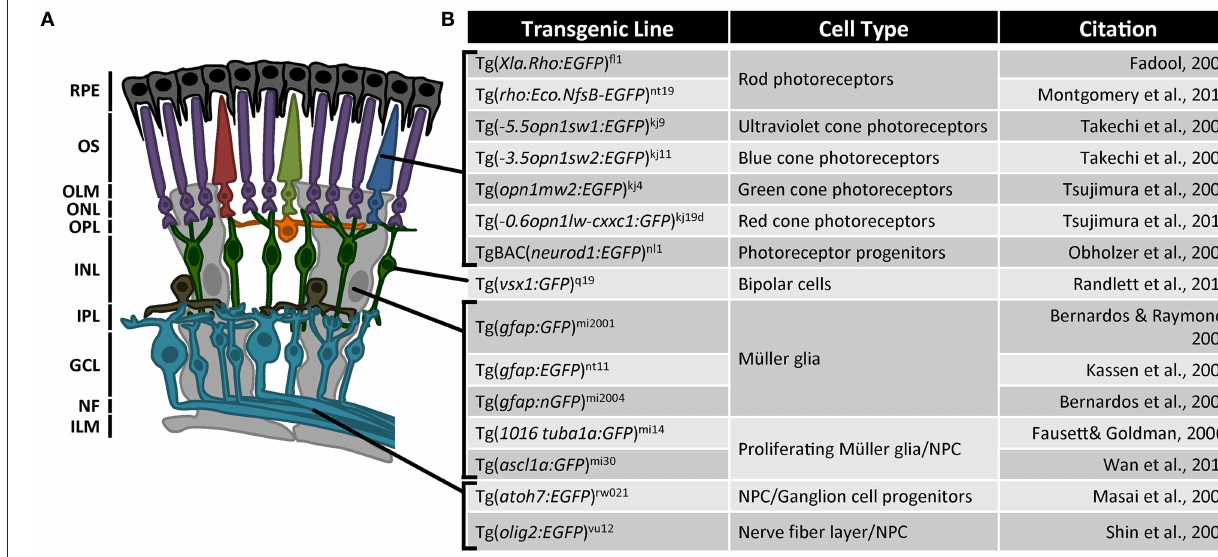
FIGURE 1 | Transgenic reporter lines used in zebrafish retinal regeneration research. (A) The vertebrate retina is a laminated structure with different neurons located in the distinct layers. RPE, retinal pigmented epithelium; OS, outer segments; OLM, outer limiting membrane; ONL, outer nuclear layer; OPL, outer plexiform layer; INL, inner nuclear layer; IPL, inner plexiform layer; GCL, ganglion cell layer; NF, nerve fibers; ILM, inner limiting membrane. (B) List of transgenic reporter zebrafish lines for retinal regeneration research. Fadool (2003), Masai et al. (2003), Shin et al. (2003), Takechi et al. (2003, 2008), Bernardos and Raymond (2006), Fausett and Goldman (2006), Bernardos et al. (2007), Kassen et al. (2007), Tsujimura et al. (2007, 2010), Obholzer et al. (2008), Montgomery et al. (2010), Wan et al. (2012), Randlett et al. (2013)